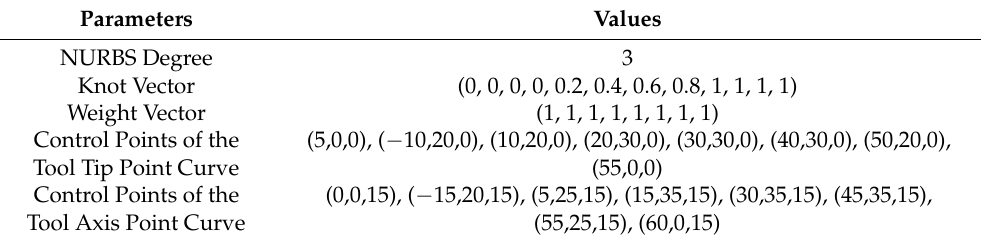
Table A1. Parameters of the Open-Pocket Curve.